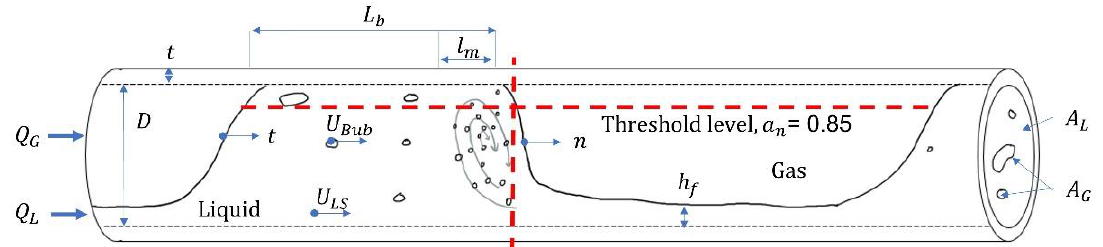
Figure 5. Illustration of slug flow and the notations used to describe flow characteristics.